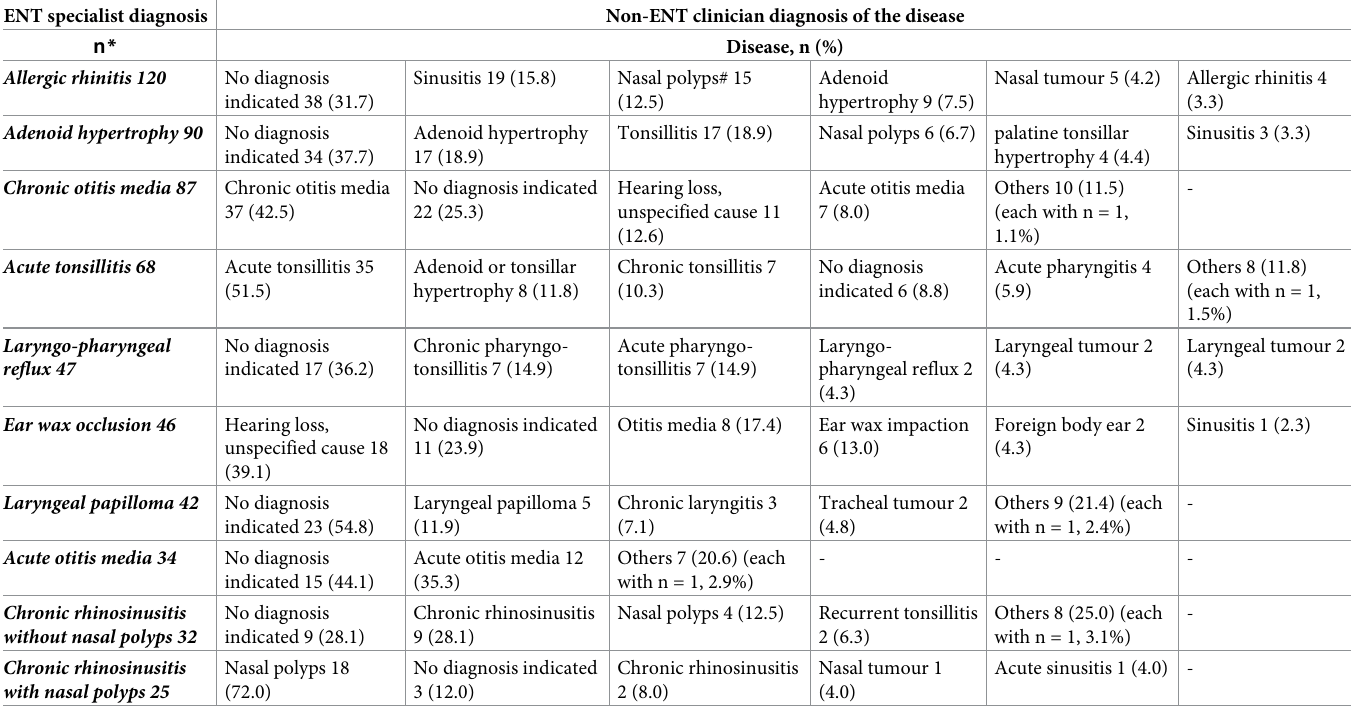
Table 1. Disease diagnosis comparison between ENT specialist and non-ENT clinicians. ENT specialist diagnosis Non-ENT clinician diagnosis of the